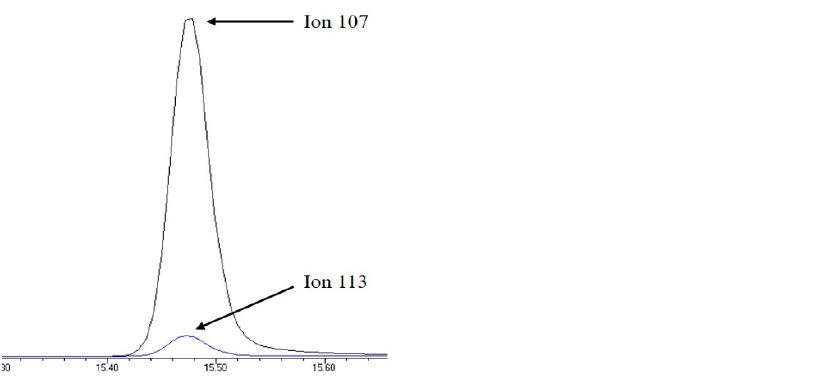
Figure 2. Selected ion chromatogram of quantifier ions for 4-n-NP and 4-n-NP 13 C 6 .